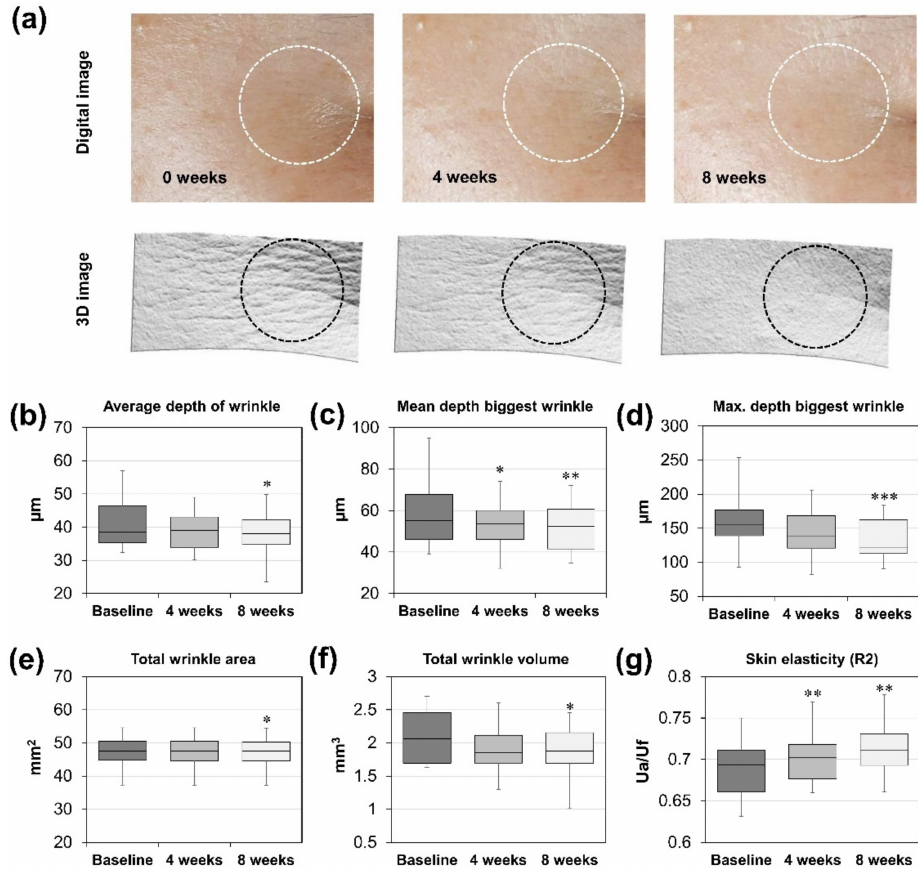
Figure 5. The anti-aging effect of CFE on human skin. ( a ) Skin wrinkles images following 8 consecu- tive weeks application of CFE. ( b – f ) Statistical analysis of skin wrinkles. ( b ) Average depth of wrinkle. ( c ) Mean depth of the biggest wrinkle. ( d ) Maximum depth of the biggest wrinkle. ( e ) Total wrinkle area. ( f ) Total wrinkle volume. ( g ) Statistical analysis of skin elasticity. Statistical significances were represented as follows: *, p < 0.05; **, p < 0.01; ***, p < 0.001 compared to